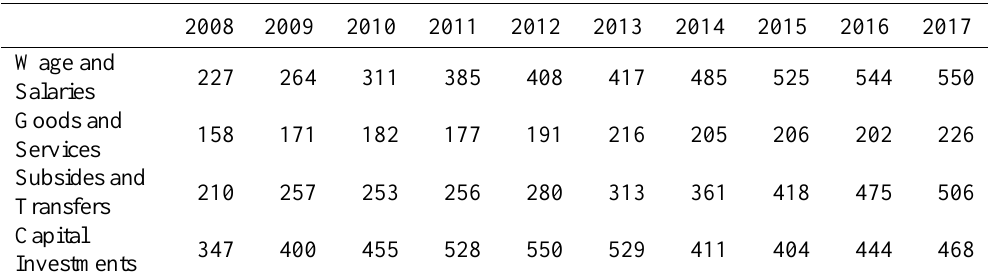
Table 4. Budget Outlays (millions of